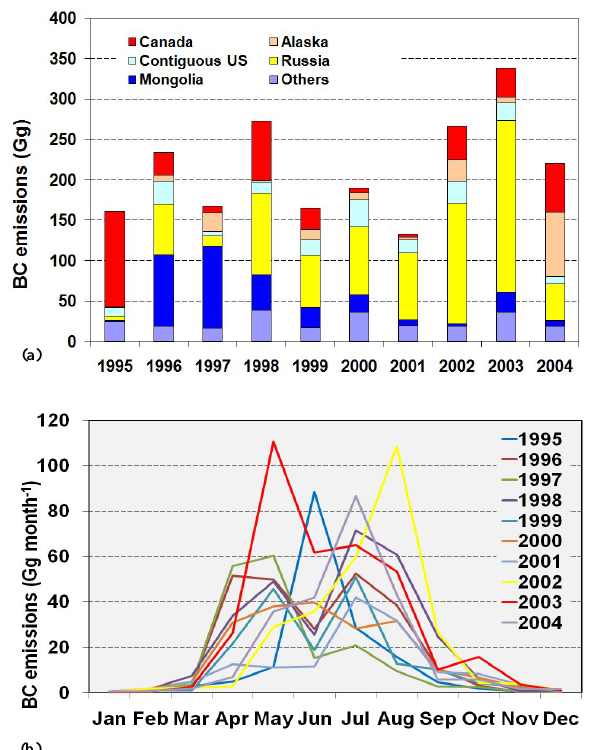
Fig. 5. Inter-annual (a) and monthly variability (b) of black carbon emitted by wildland fires in the boreal and temperate